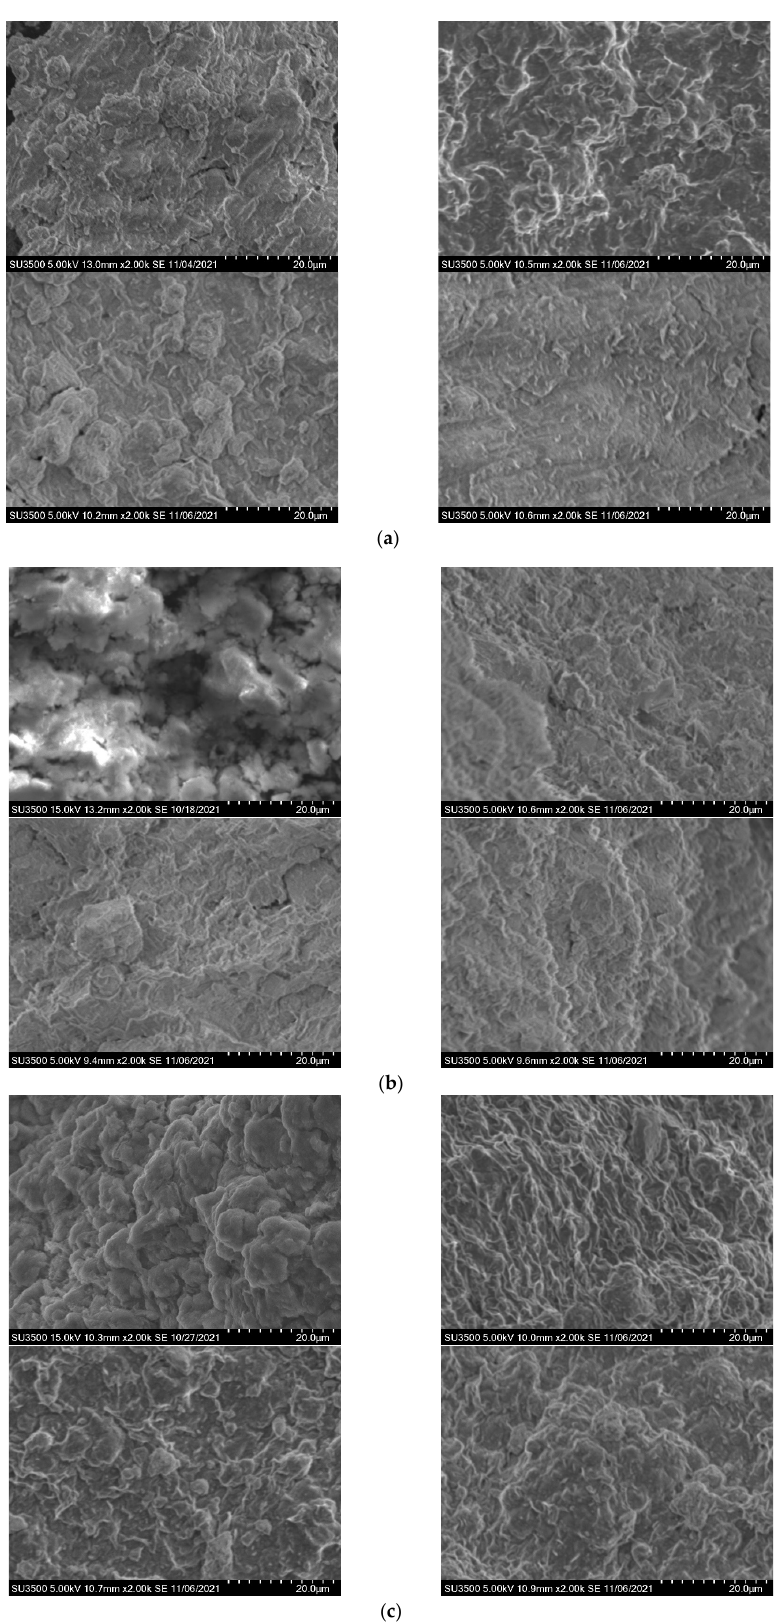
Figure 5. SEM images of bentonite A with test solutions at various temperature. (( a – c ) are Bentonite A with deionized water, Baojinshan mining leachates, and Xikuangshan mining leachates, respec- tively, at room temperature, 50 °C, 60 °C, and 70